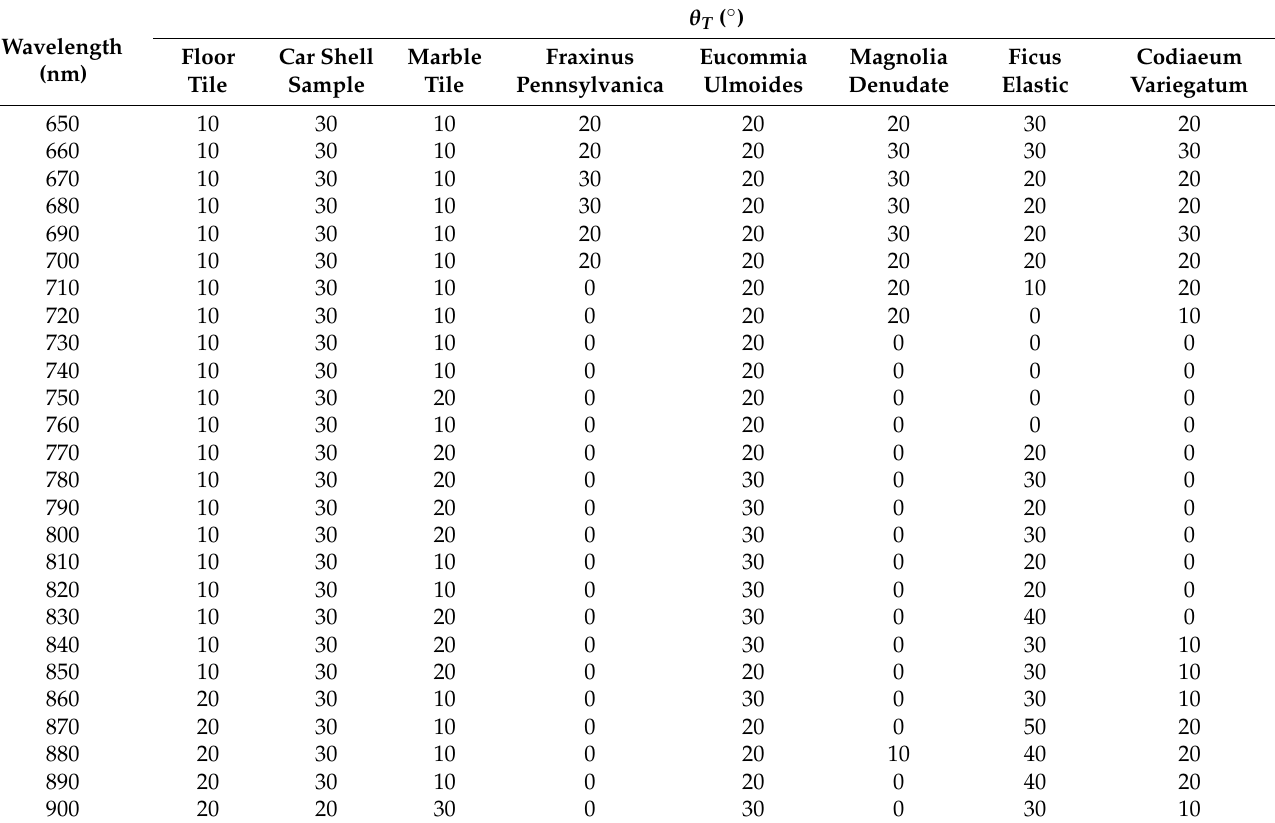
Figure 8. The relationship between roughness parameter, m, and wavelength, λ . ( a ) Non-leaf samples; ( b ) Leaf samples. Table 2. The relationship between θ T and different wavelength.